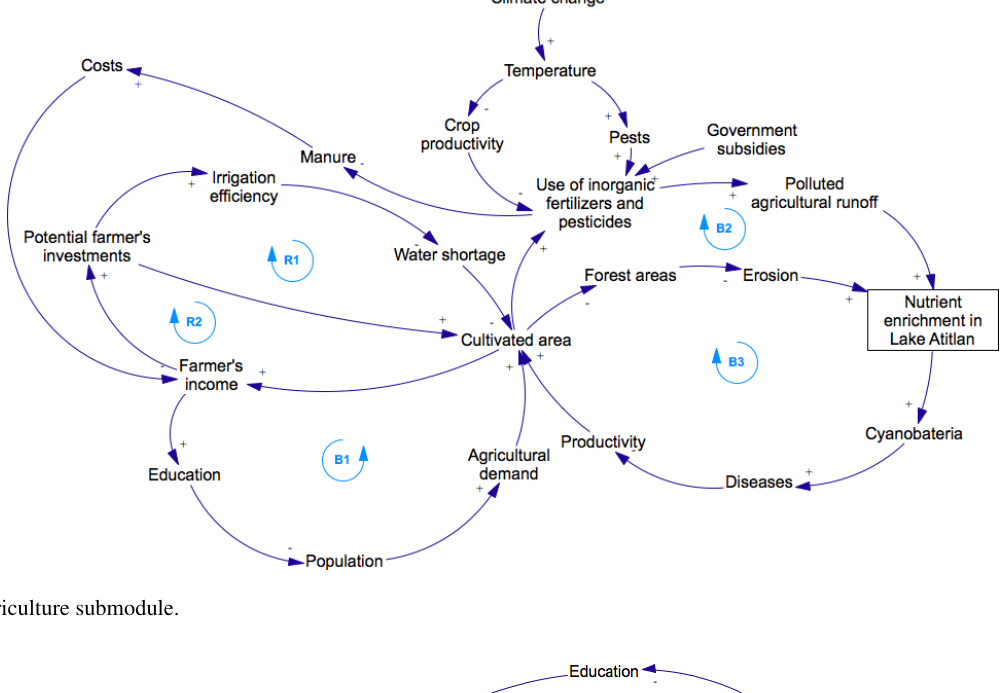
Figure 8. Agriculture submodule.